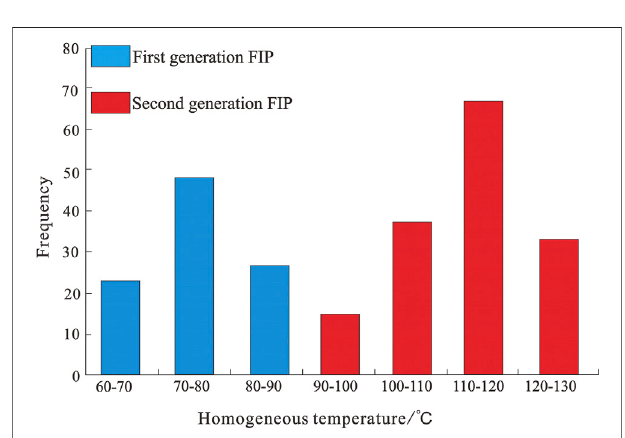
FIGURE 7 | Homogenization temperature data from 12 wells, with the main peak distributed in the range of 70 – 80 ° C and 110 – 120 ° C.